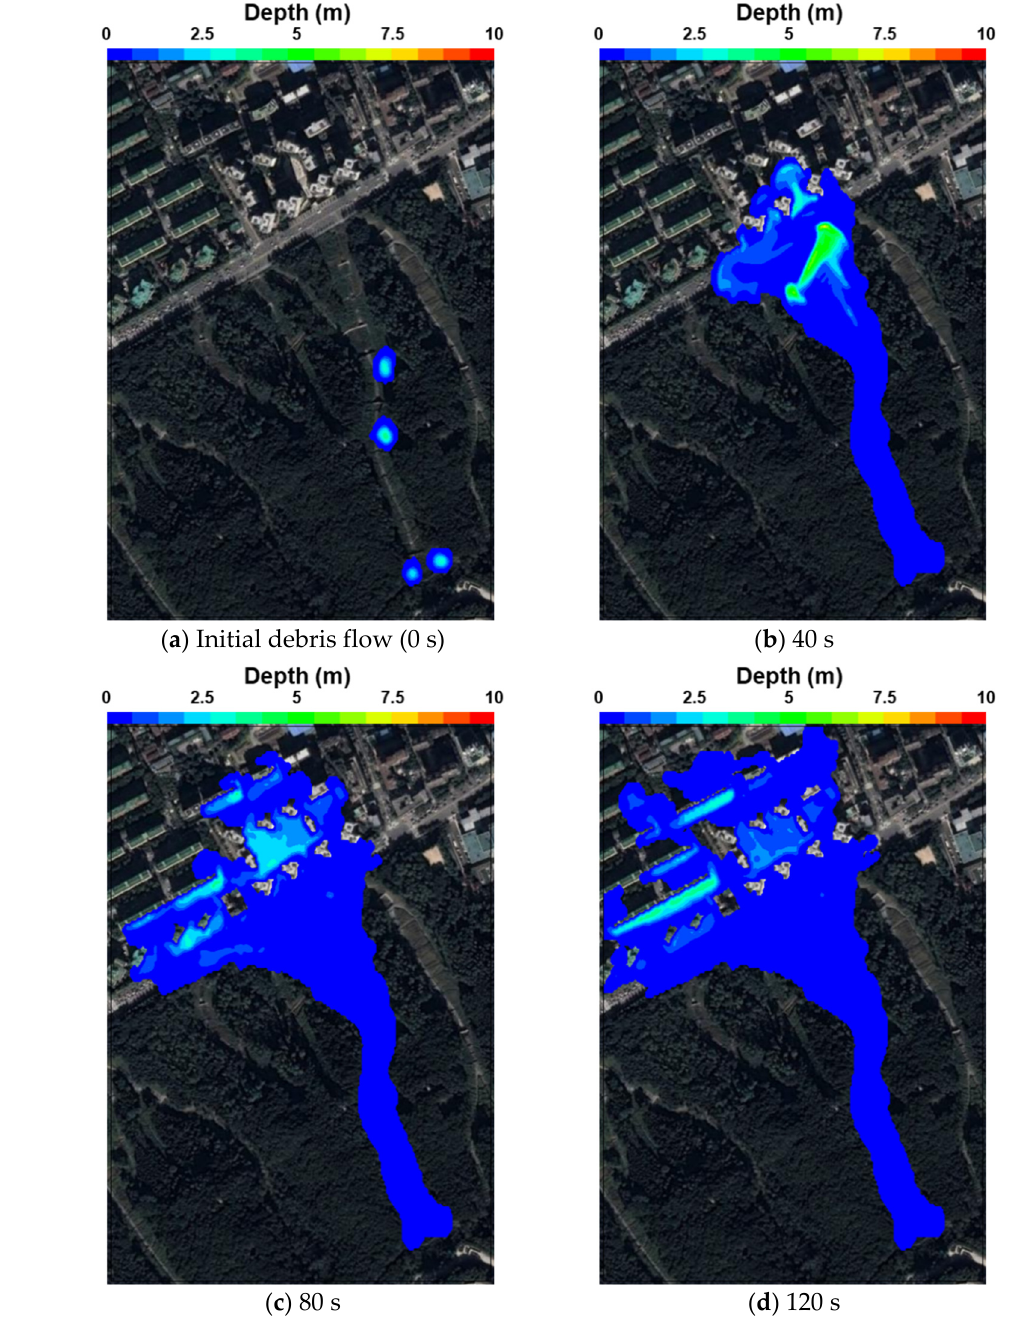
Figure 4. Time changes in simulation result of debris-flow depth (Run2).